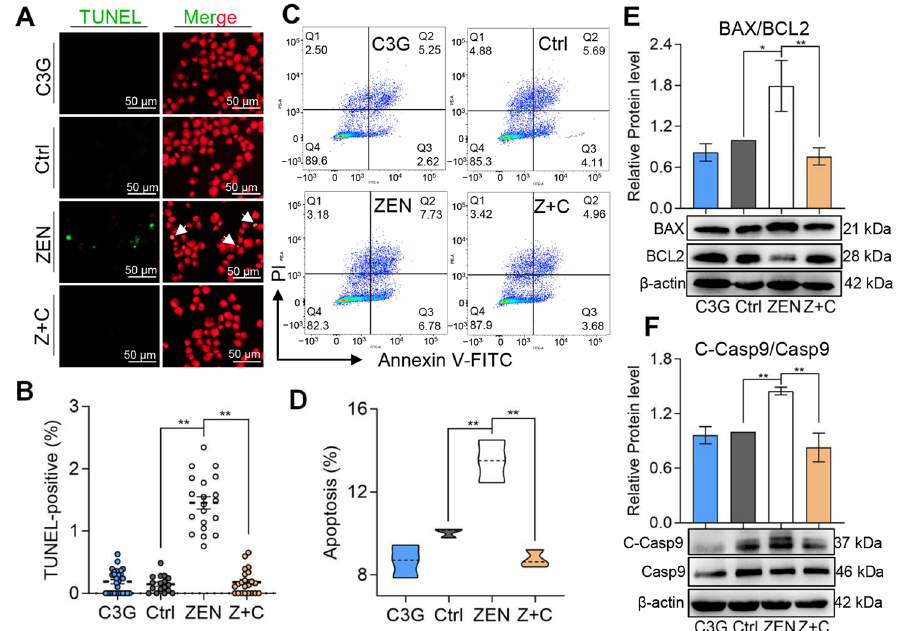
Figure 2. Effects of C3G on ZEN-induced apoptosis in pGCs. ( A ) Immunostaining of TUNEL (green) in pGCs between Ctrl, ZEN, Z+C, and C3G groups. Nuclei were stained with PI (red). The white arrows represent positive cells; scale bar = 50 µm. ( B ) Representative results of TUNEL-positive cell proportion determined from images in ( A ); n = 18, 20, 22, and 29. ( C ) Apoptosis was detected by flow cytometry using Annexin V-FITC/PI staining. ( D ) Representative results of apoptosis cell proportion determined from ( C ); n = 3. ( E , F ) The relative protein levels of BAX/BCL2 ( E ) and C-Casp9/Casp9 ( F ) as detected by WB. All data were quantified as mean ± SEM. All experiments were repeated at least 3 times. * p < 0.05, ** p < 0.01.